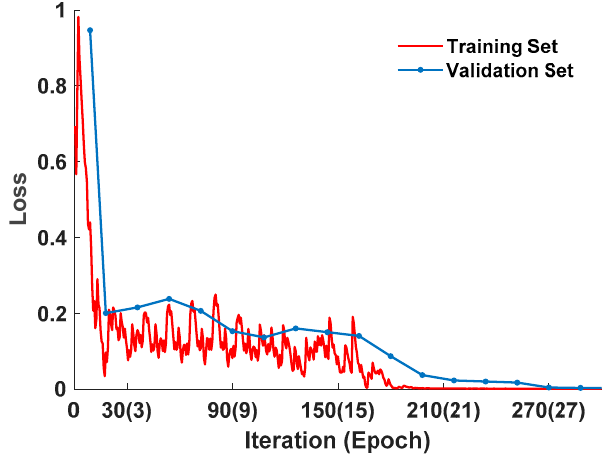
Figure 11. The loss value during model training.